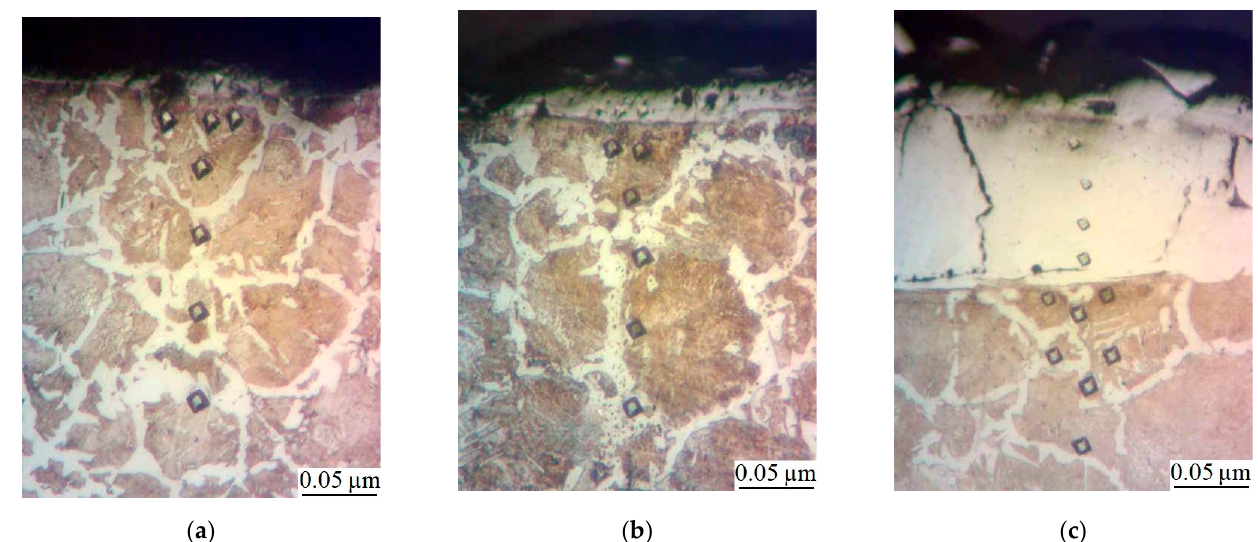
Figure 3. Distribution of microhardness in the surface layer of steel C22 after sulfomolybdenizing